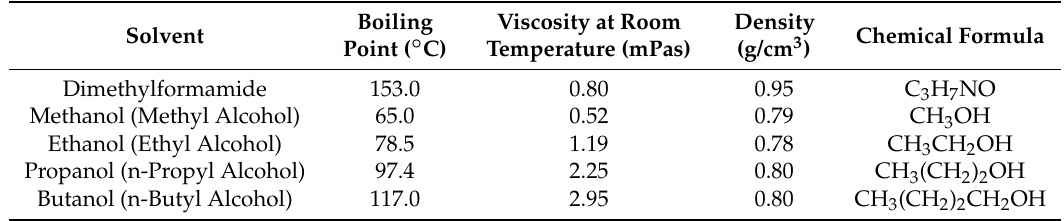
Table 2. Physical properties of a few solvents used during the deposition of some high- K dielectrics.